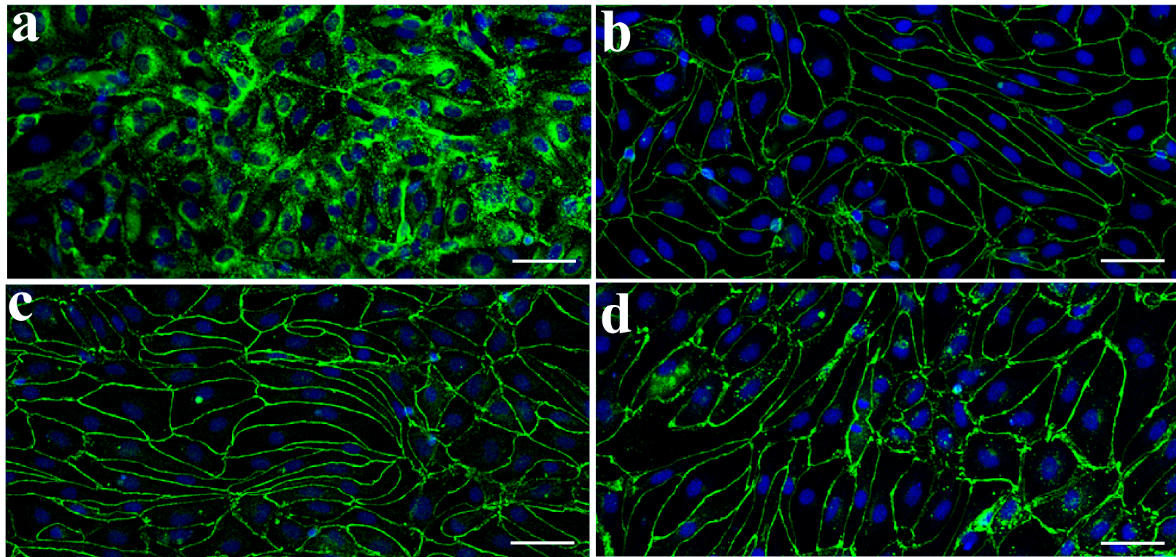
Figure 1. Characterization of primary monkey brain endothelial cells (MBECs) by immunofluorescence microscopy. MBECs express factor VIII-related antigen/von Willebrand factor ( a ). Tight junction protein ZO-1 ( b ), occludin ( c ), and claudin-5 ( d ) are expressed along the cell-cell border. Nuclear counterstain was stained with TO-PRO-3 (blue). Scale bar = 50 μ m.